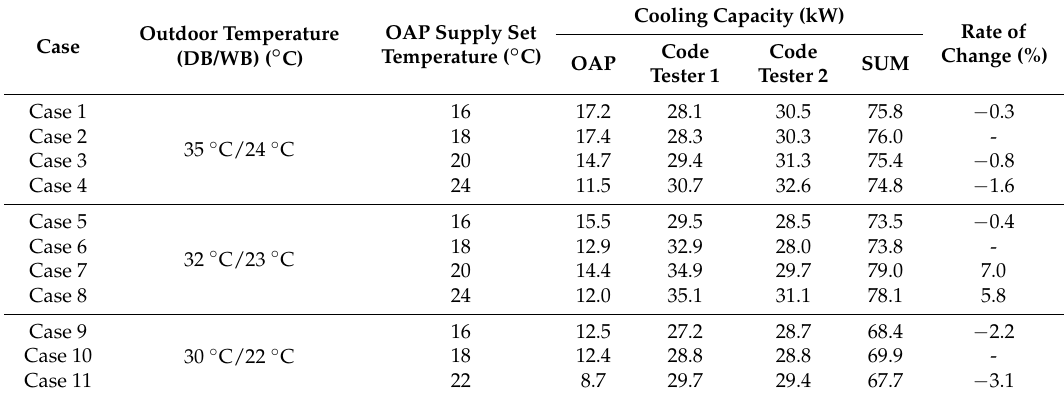
Table 4. Changes in cooling capacity according to a supply air temperature.